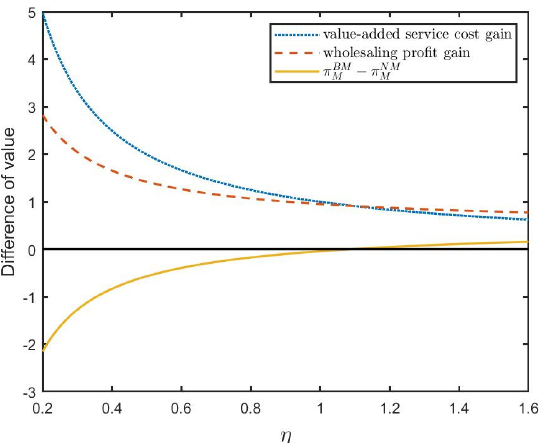
Figure 4. Impact of η on the manufacturer in Model iM ( i = N , B ) . ( α = 2.2, σ = 0.2, φ =